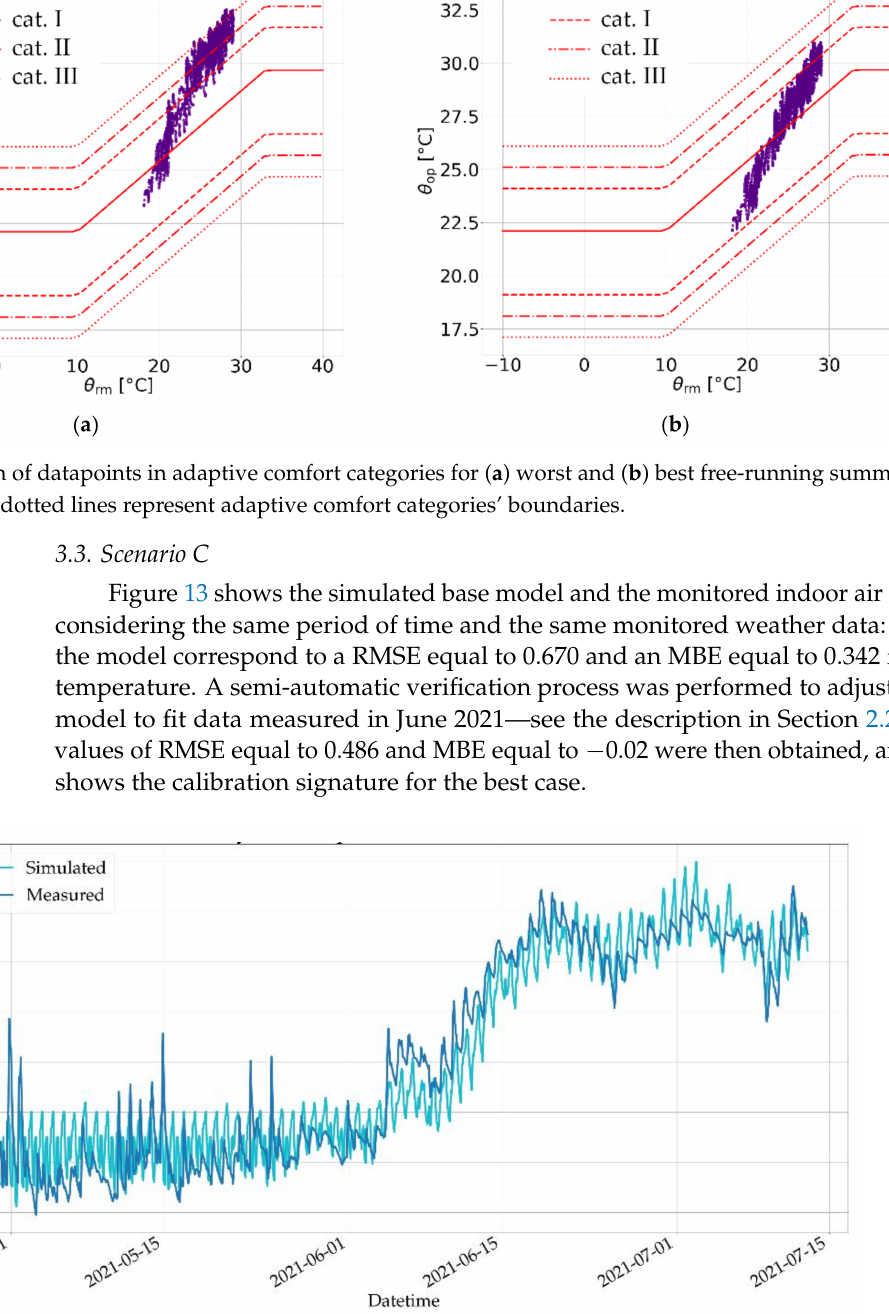
Figure 13. Indoor air temperatures simulated and measured over the period of time, considering base building model (not